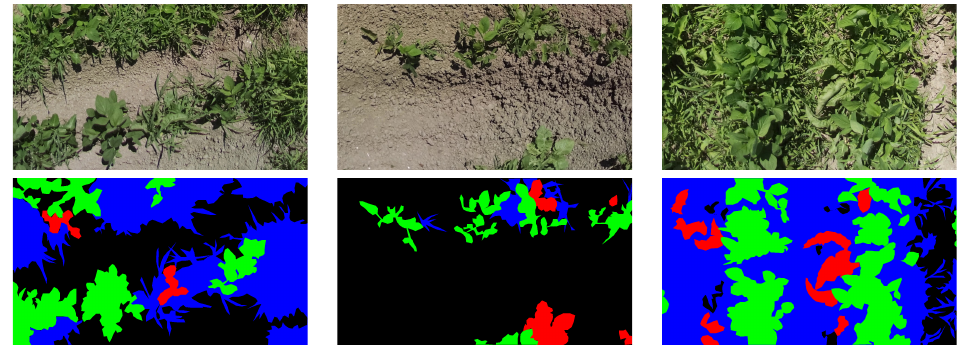
Figure 5. Sample images of Soybeans: source images ( upper ) and GT images ( lower